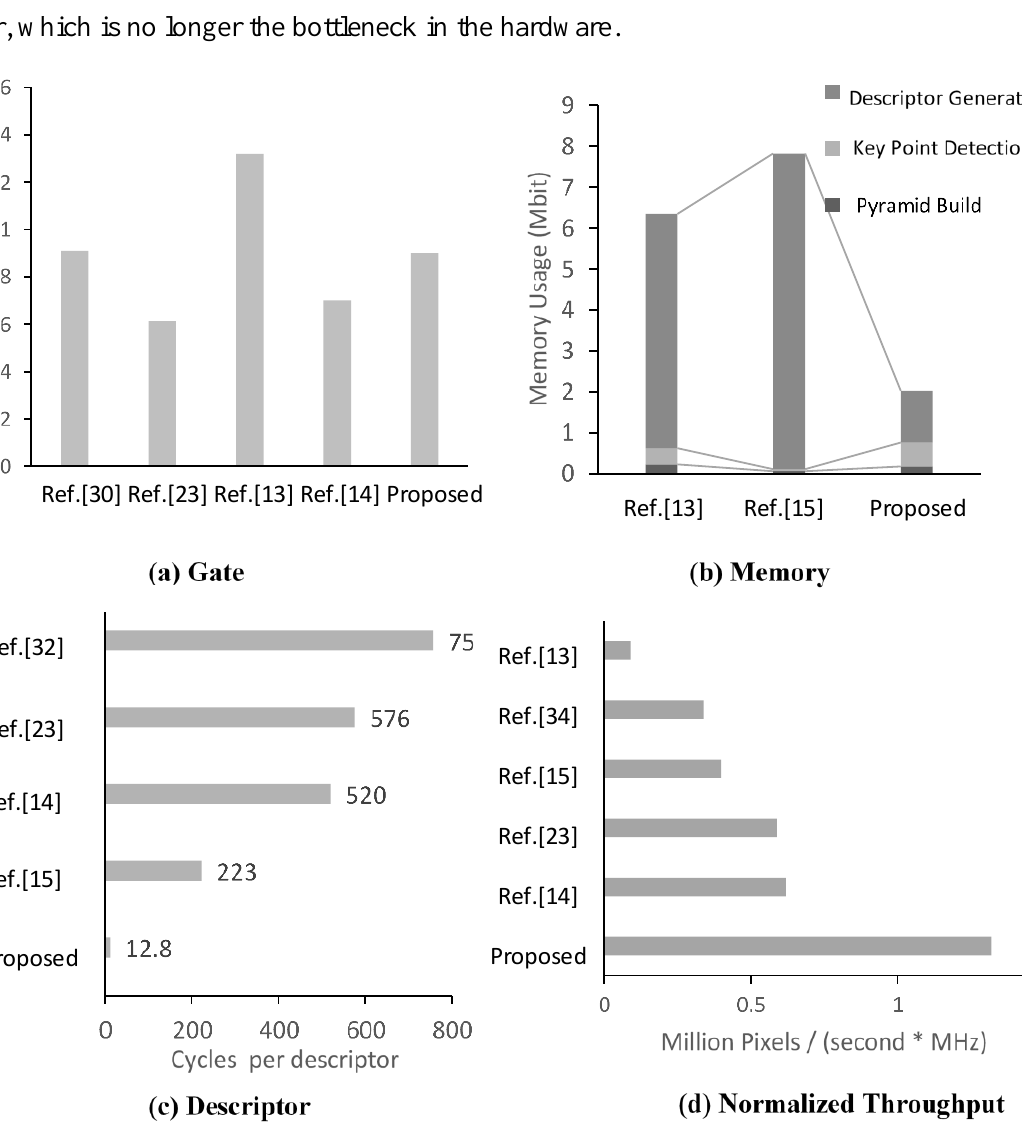
Figure 12. Comparison of hardware cost ( a , b ) and process speed ( c , d